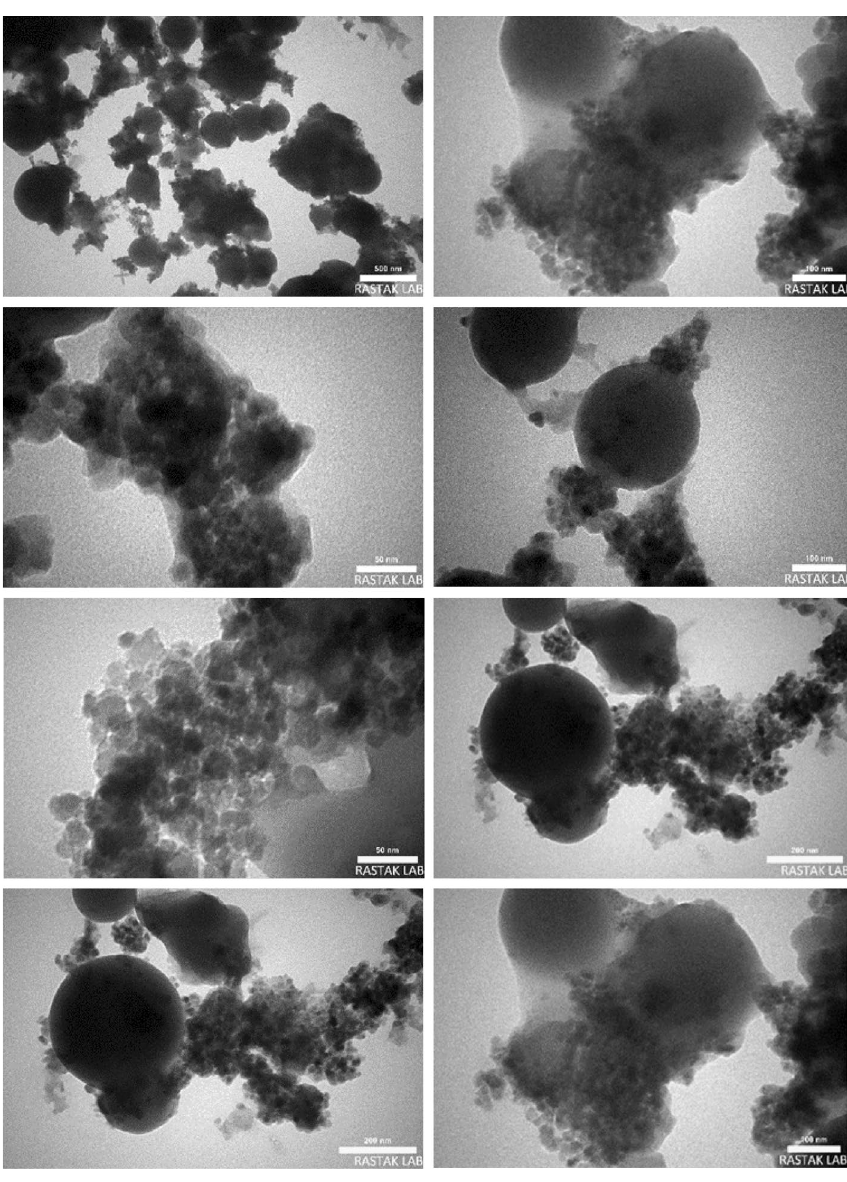
Figure 9. The TEM images of the FSiPSS